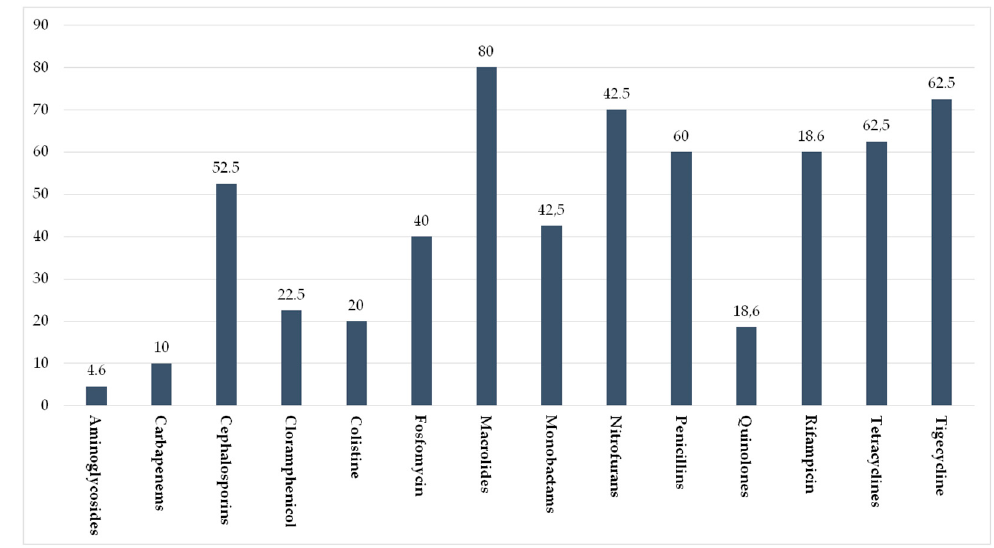
Figure 4. General percentage resistance of the detected bacterial strains to the used antibiotic families.